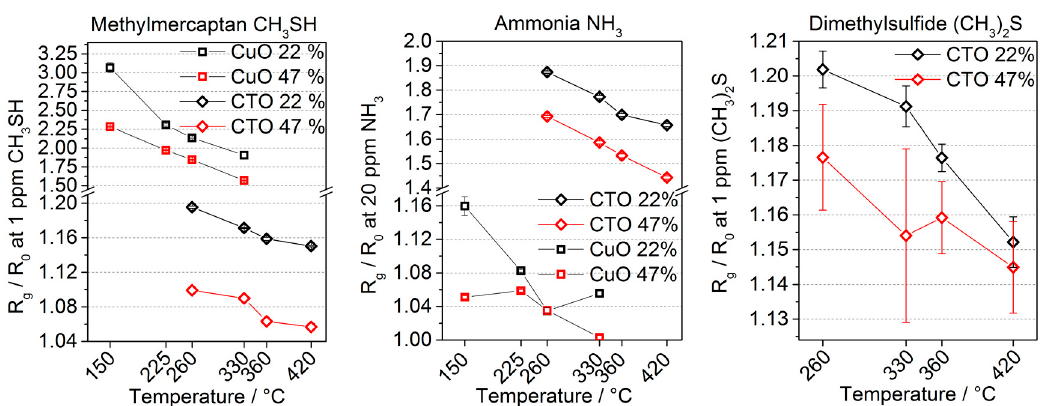
Figure 9. The gas sensitive reaction of the metal oxide layers towards test gas concentrations of 1 ppm of either dimethlysulfide or methylmercaptan and 20 ppm of ammonia. These concentrations are close to the head space concentrations reported in real samples, thus demonstrating detection limits are below these concentrations. The graphs also highlight the increase in selectivity achieved by using different temperatures to operate the metal oxide layers. On the right hand panel, again, no CuO reaction is shown, because the response was negligible.